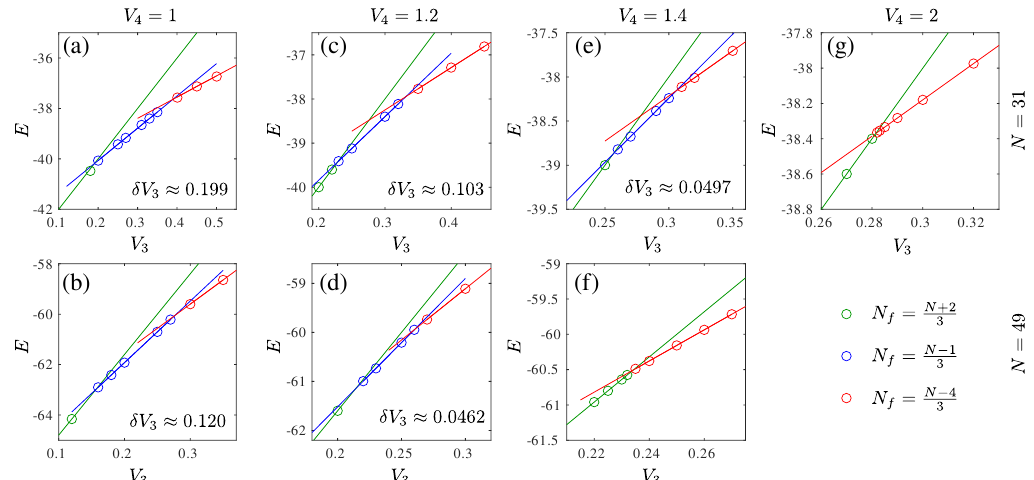
Figure 6: Crossings of the ground state energy for systems with OBC in the vicinity of the period-3 phase boundary and N = 31 (top) and N = 49 (bottom) between = N − 1 + 1 (green), one fermion less (blue) and two the fully packed state with N f 3 fermions less (red). The interval of the single-particle instability δ V is indicated on 3 panels (a)-(e) and is decreasing with N , indicating its finite-size nature. Upon in- = 1 (a)-(b) the ground state changes from the fully packed state to creasing V for V 3 4 a state with one fermion less, then with two fermions less etc. However, starting from ≈ 1.2 and above the width of the single-fermion instability vanishes rapidly with V 4 the system size and for sufficiently large system the period-3 state changes directly = 1.4 we do not observe a single-fermion into a state with two fermions less. For V 4 = 2 a single-fermion insta- instability as a ground state for N = 49 and larger; for V 4 bility does not show up for systems as small as N = 31.